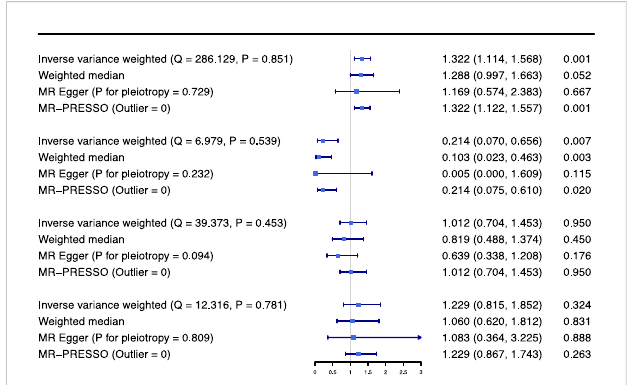
FIGURE 2 Mendelian randomization results for association between smoking traits and coronary artery disease in patients with diabetes. Odds ratio is scaled to per standard deviation increasement in genetically determined smoking initiation (about 10-12% increasement in the probability of being a regular smoker), age at initiation of regular smoking (about additional 0.31-0.50 years), cigarettes per day (about additional 2-3 cigarettes daily) and smoking cessation (about 3-5% increasement in the probability of being a current smoker). OR indicates odds ratio; CI, con fi dence interval; SmkInit, smoking initiation; AgeSmk, age at initiation of regular smoking; CigDay, cigarettes per day; SmkCes, smoking cessation; MR, Mendelian randomization; MR-PRESSO, MR Pleiotropy Residual Sum and Outlier.